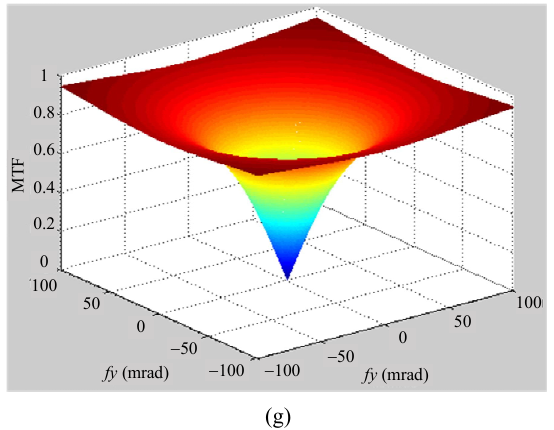
Fig. 4 MTF distribution maps: (a) diffraction effect, (b) aberration effect, (c) spatial filtering effect, (d) temporal filtering effect, (e) CCD transfer effect, (f) low-pass filtering effect, and (g) high-pass filtering effect. Table 1 Model parameters of signal acquisition unit.